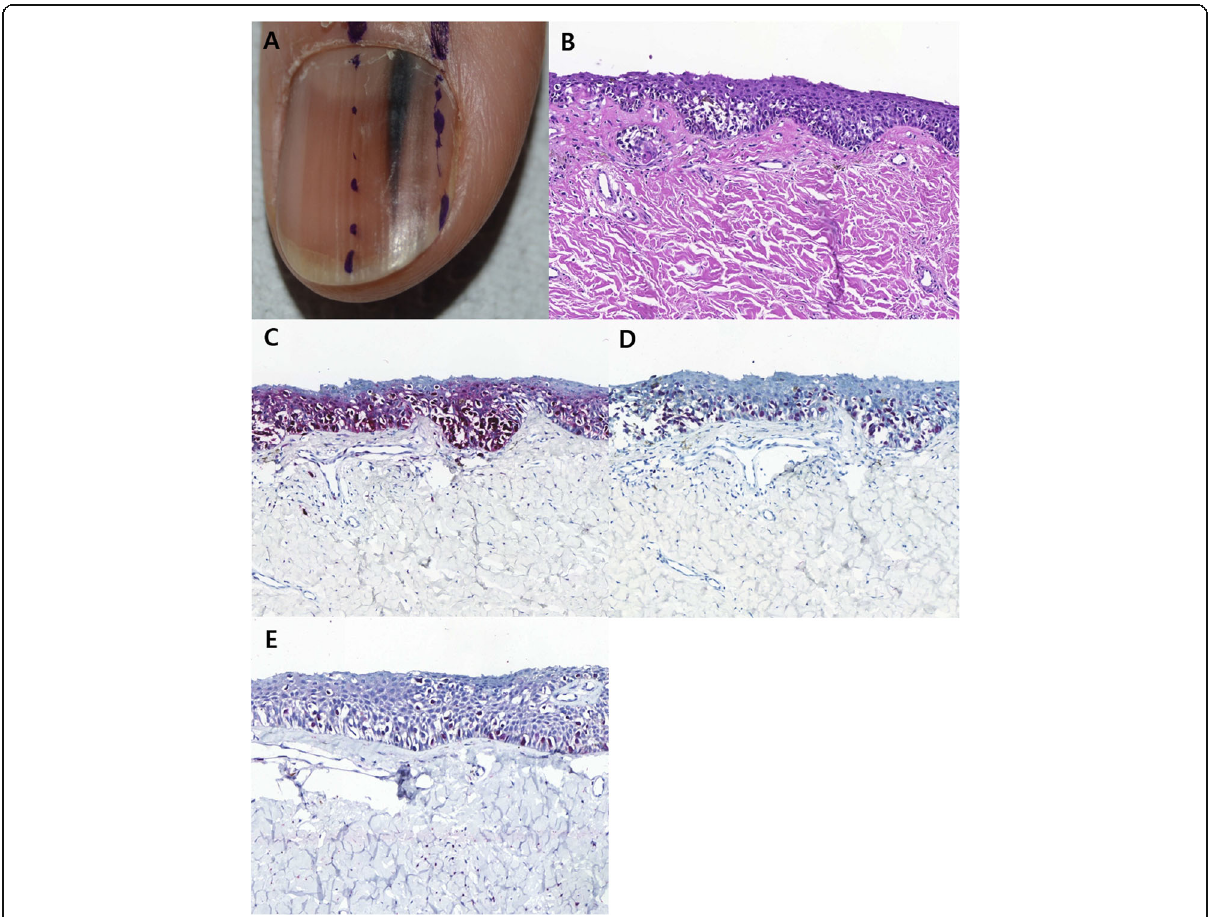
Fig. 2 Representative clinical morphology, photomicrographs of H&E staining, and IHC staining for cyclin D1 and PRAME of selected subunugal melanoma in situ. One 44-year-old patient ( A ) 2 mm-wide melanonychia showed ( B ) atypical melanocyte proliferation with confluency and pagetoid spread (200x magnification, H&E). Both ( C ) cyclin D1 and ( D ) PRAME IHC showed over 90% nuclear immunostaining (200x magnification, respectively), ( E ) Sox-10 IHC (200x